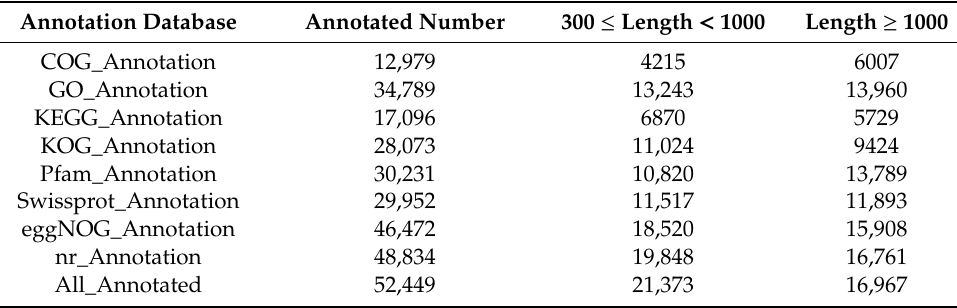
Table 3. Functional annotation statistics of the